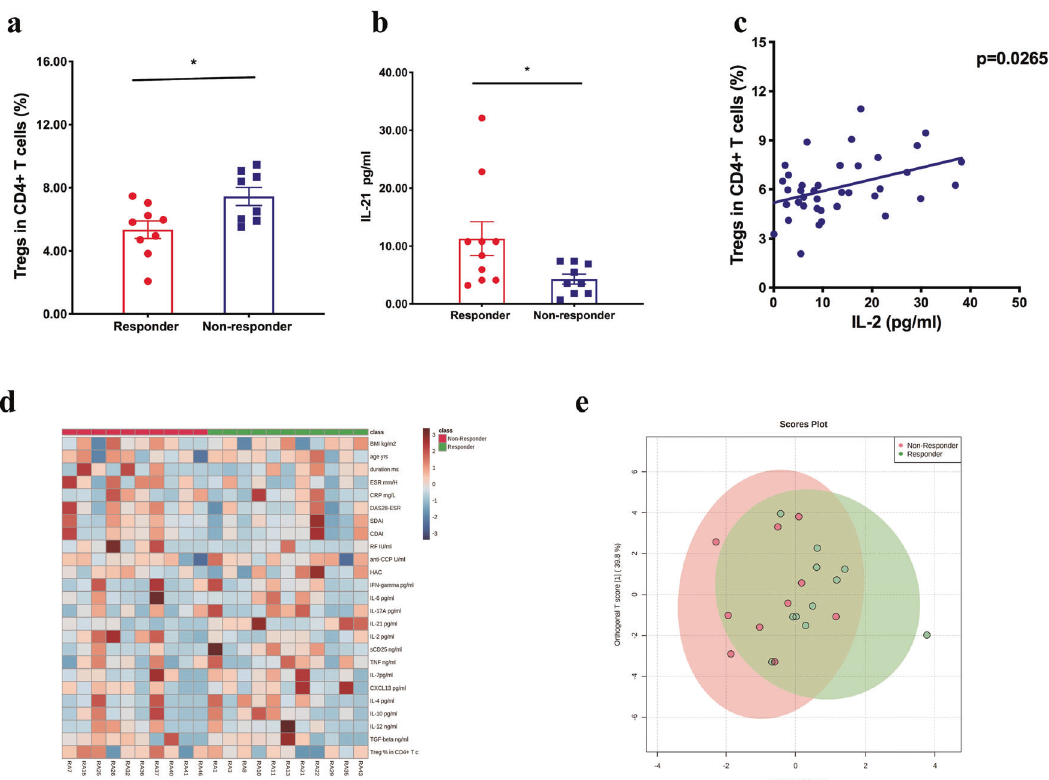
Fig. 3 Predictive biomarkers for potential response to Ld-IL2 treatment in RA. The percentage of regulatory T cells (Tregs) in CD4 + T cells and serum level of IL-21 in responders and non-responders ( a, b ). The correlation between percentage of Tregs and serum level of IL-2 ( c ). Heatmap showed a classi fi cation of the two groups ( d ). Each column represented an individual. Colors in the horizontal bar denoted the non- responder group (red) and the responder group (green). Tiles were colored based on clinical features, Tregs and serum cytokine levels, red and blue indicating high and low levels, respectively. Primary composition analysis ( e ). The non-responder group was shown in red, and the responder group was shown in green. PC1 and PC2 account for 39.8% and 14%, respectively, of the total variance. Panels d and e were performed by R 4.1.0 and R-packages (mixOmics and pheatmap) (http://www.metaboanalyst.ca). Data in graphs were mean ± SE. * P <